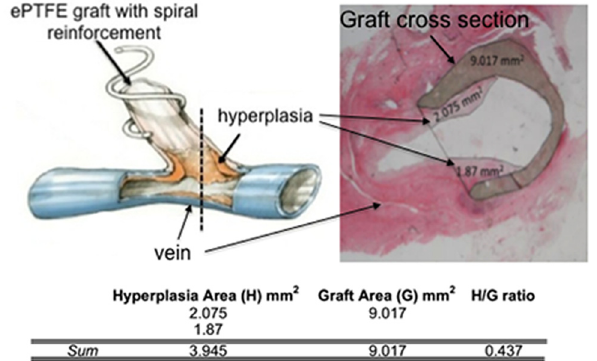
Fig 3. Hyperplasia-to-graft (H/G) ratio analysis example. The dashed line in the cartoon of the vein and graft on the left indicates the approximate region at the vein-graft anastomosis where the histological section, shown on the right, was collected. A line was drawn across the mouth of the graft on a digitized image of the histological section then the areas of the graft and the hyperplasia growing into the lumen of the graft were measured using NIH Image J and are shown on the histology image. The table shows the sum of the areas of the hyperplasia and the graft and then the H/G ratio results for that histological section.